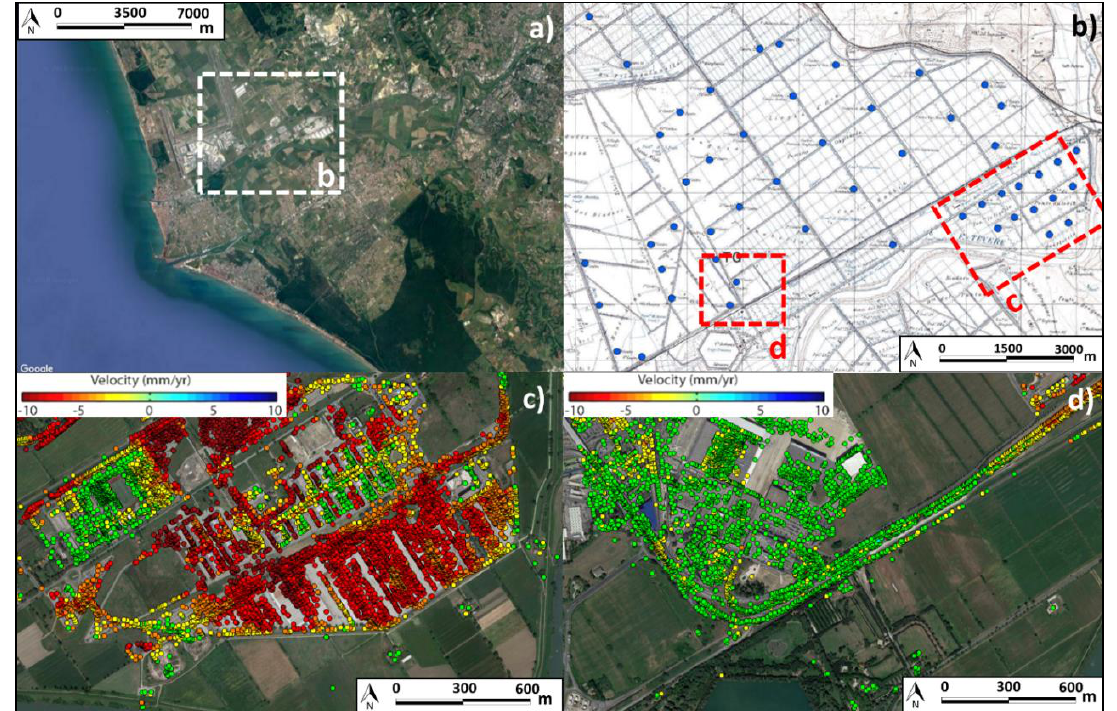
Figure 16. ( a ) Location of the detailed view (reported in ( b ) on the north-eastern sector of the deltaic plain; ( b ) Location of the main farmhouses over a 1:25.000 topographic map (I.G.M). The red polygons in ( b ) indicate the location of the detailed views of the PS velocity map reported in ( c , d ), in which the farmhouses are clearly visible.